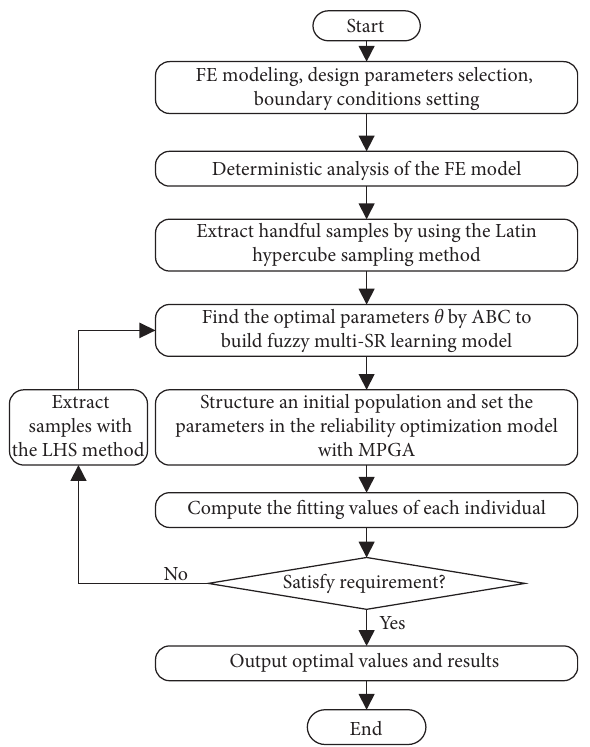
Figure 1: Reliability optimization procedure with the ISRM method. Table 1: Distribution features of input